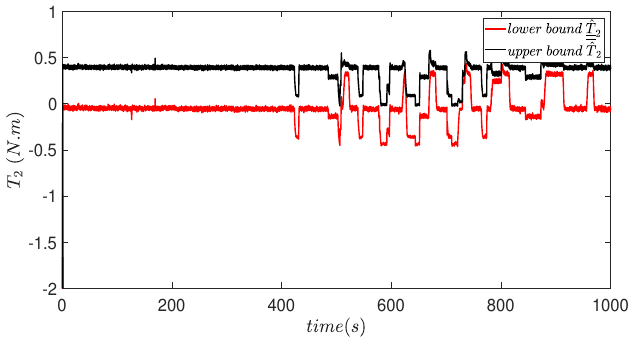
Figure 12. Upper and lower bound estimations of T 2 ( k ) .